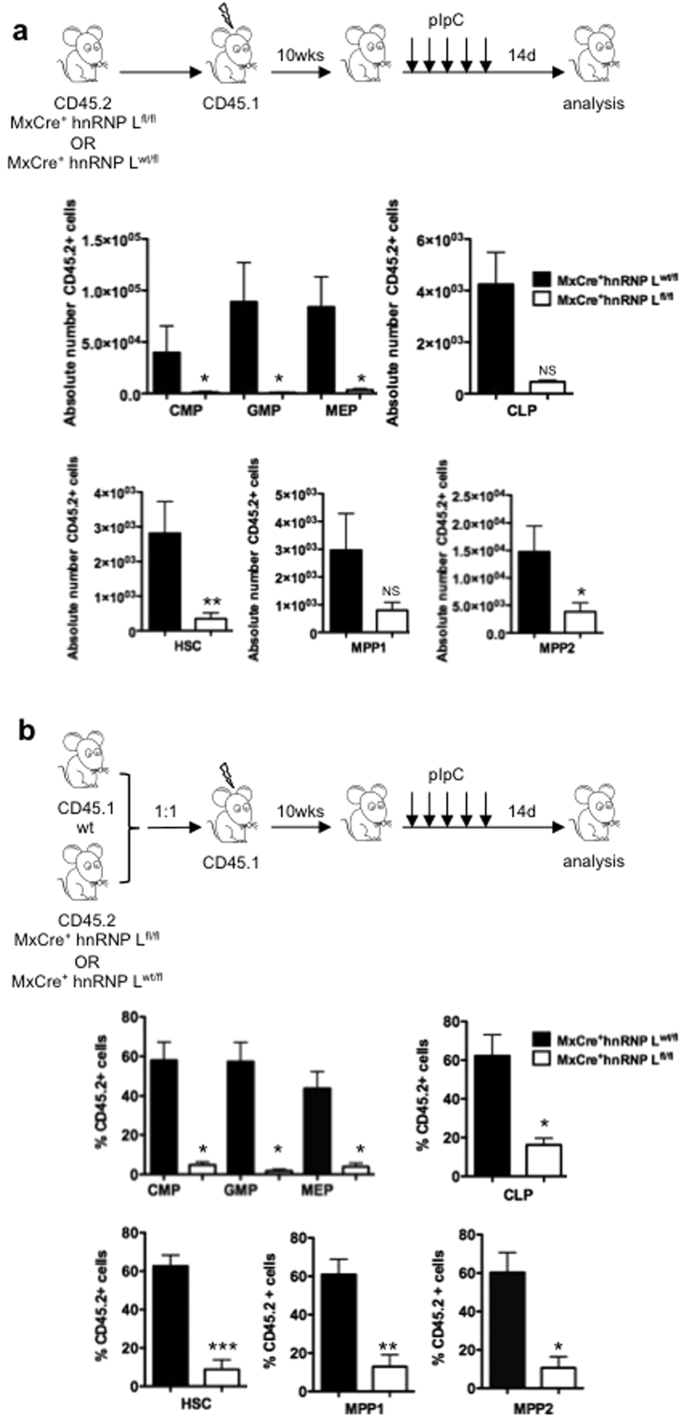
hnRNP L is required for HSCs and progenitor cells repopulation capacity.(a) Transplantation of total BM cells from MxCre+hnRNPLwt/fl or MxCre+hnRNPLfl/fl mice into irradiated syngenic CD45.1+ recipient mice. Ten weeks post-transplantation reconstitution was tested and mice were injected five times every other day with 500μg of pIpC and analyzed 14 days later. The frequency of CD45.2+ cells and absolute cells numbers were quantified for progenitors and HSCs in the BM (n = 4). (b) Competitive transplantation of total BM cells from MxCre+hnRNPLwt/fl or MxCre+hnRNPLfl/fl mice mixed with wt CD45.1+ BM cells at a ratio of 1:1 for a total of 2 × 106 cells into irradiated syngenic CD45.1+ recipient mice and treated the same as the mice in A. (n = 4). All error bars are means ± SEM (*p < 0.01, **p < 0.001, ***p < 0.0001).